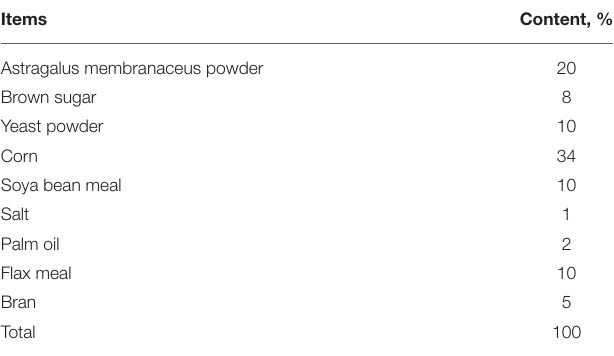
TABLE 1 | Astragalus membranaceus (AM) feed additive contents.